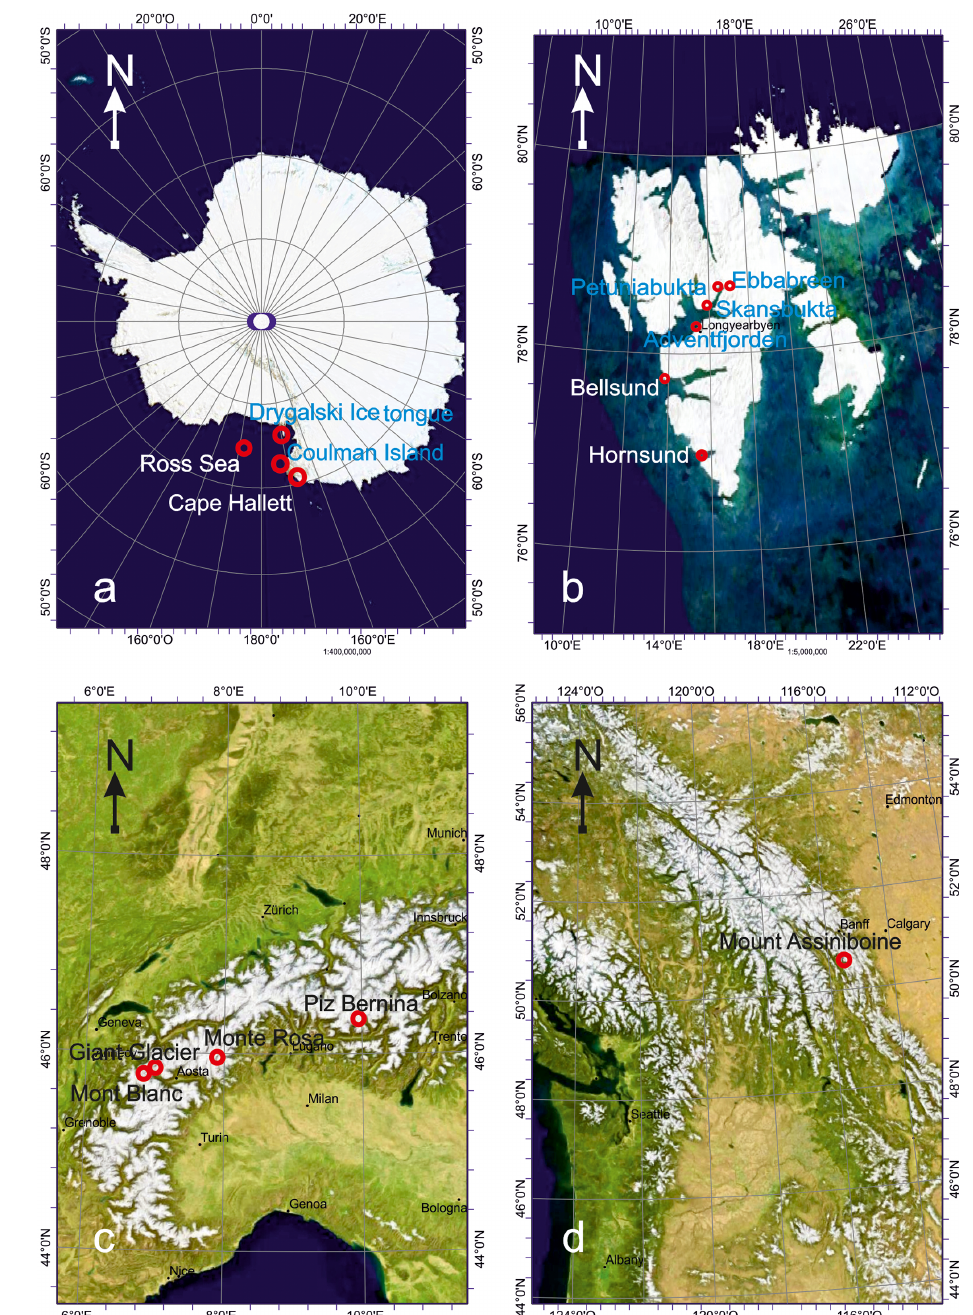
Figure 3. Maps of the geographical domains in which the pictures from the exhibition were taken. (a) Antarctica, (b) Spitzbergen island in the Svalbard archipelago, (c) the Alpine chain, and (d) the Rocky Mountain chain in Canada. Bright Earth eAtlas base map v1.0 was used for the topography. Credit: AIMS, GBRMPA, JCU, DSITIA, GA, UCSD, NASA, OSM, and